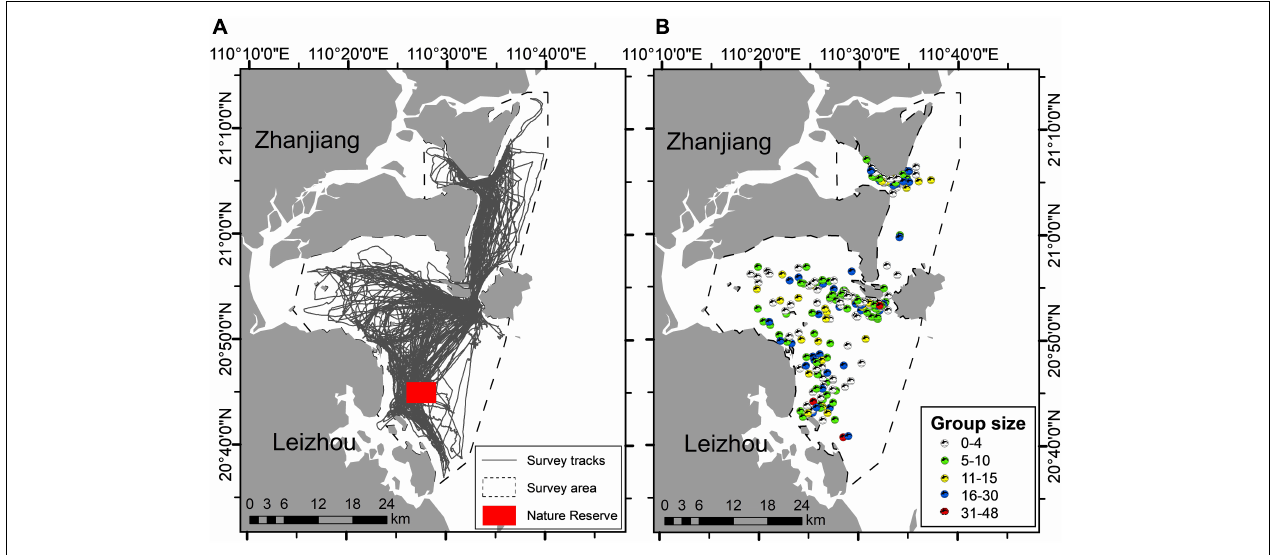
FIGURE 2 | (A) Survey routes and (B) 253 sightings of Indo-Pacific humpback dolphins achieved in the eastern waters of Zhanjiang, China in 2013, and 2015–2018.